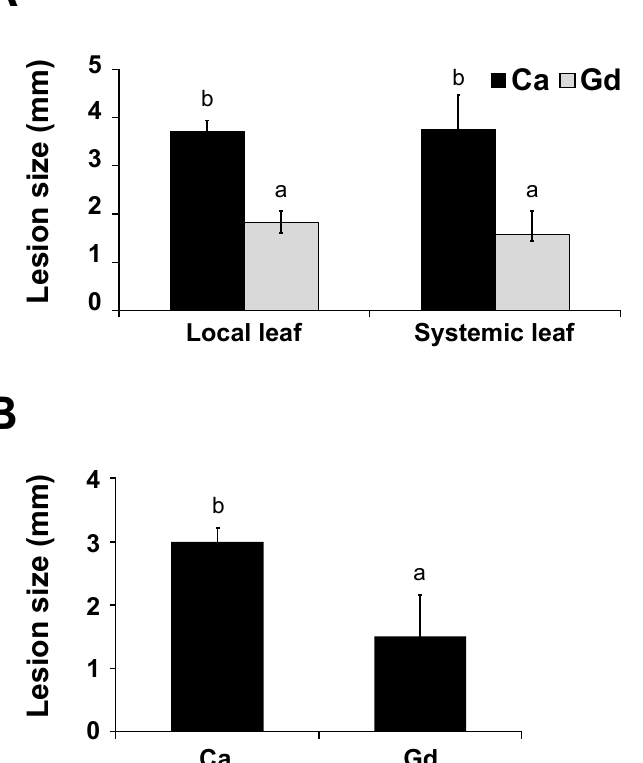
Figure 4. Systemic effect induced by Gd against B. cinerea in A. thaliana plants. Four-week-old A. thaliana plants were pre-treated as follows: ( A ) half of the rosette leaves were pre-treated with 0.2 g/L Gd or Ca (local) and the other half with H 2 O (systemic); ( B ) plants were watered until saturation with 0.2 g/L of Gd or Ca. At 24 hpt, 3 μ L droplets containing B. cinerea spore suspension (5 × 10 4 spores mL − 1 ) were applied. Infection symptoms were evaluated at 72 hpi by measuring lesion size. Bars represent mean values (±SD) of three independent experiments ( n = 30 for each experiment). Different letters above each bar represent statistically significant differences according to the Scott–Knott test ( p < 0.05).